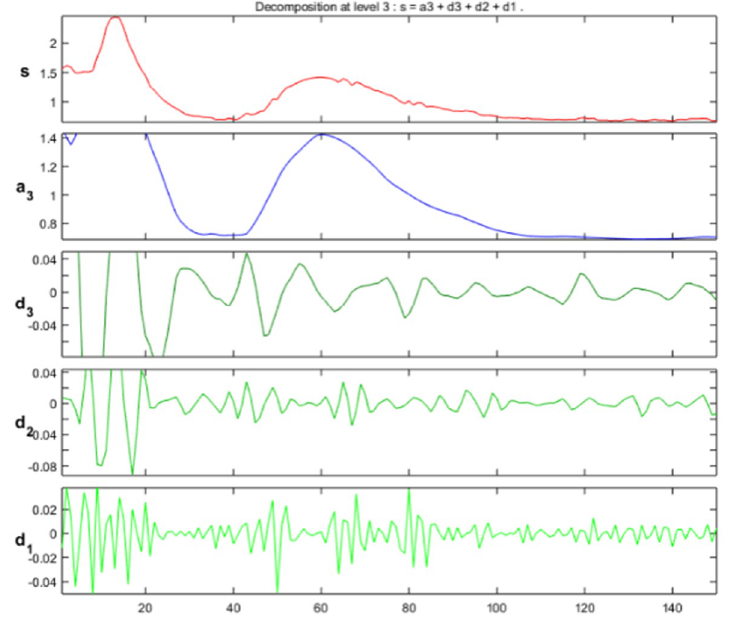
Figure 14. Example of approximation and detail coefficients, approximation to level 3 related to one upward movement.